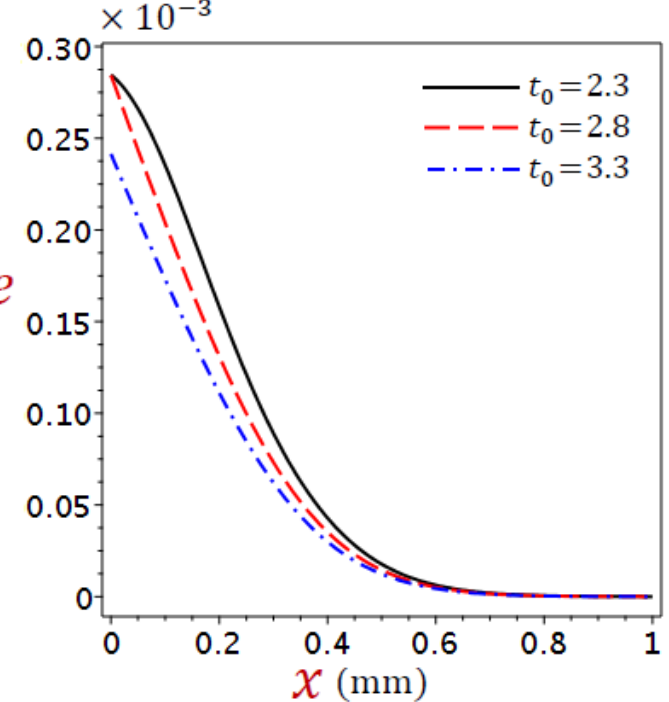
Figure 8. Variations of dilatation ( e ) across the skin tissue using numerous values of the ramp-time parameter for the refined DPL model.